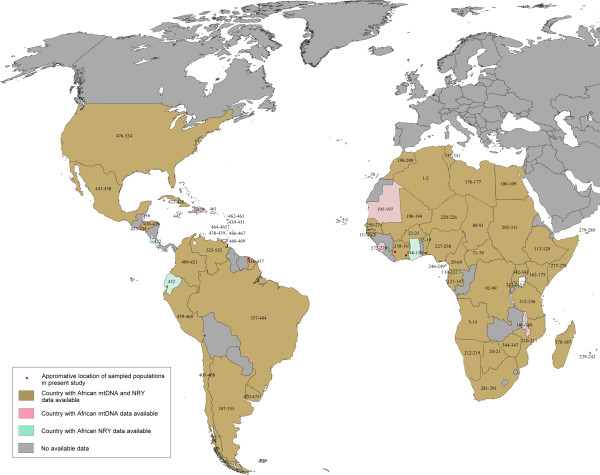
Geographic locations of populations analysed in the study. Each number refers to a unique group characterised by its ethnic name, country, the genetic system studied and the author of the corresponding study. The nomenclature and the references are available in Additional file 1.